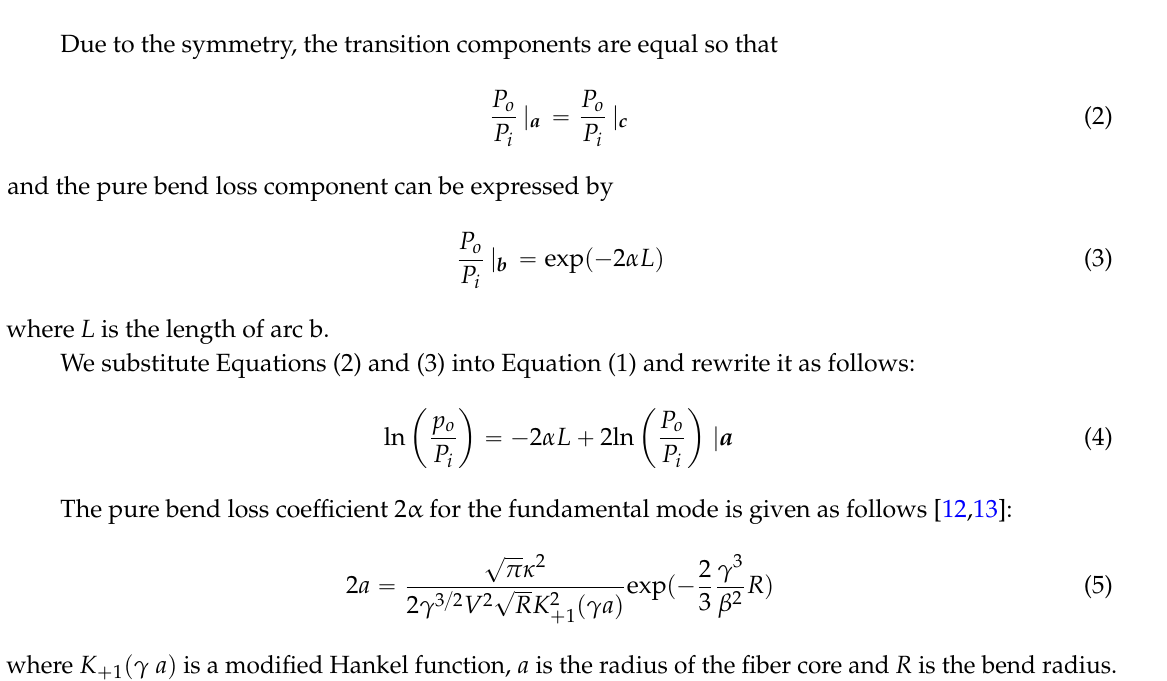
Figure 1. The input power P i and output power P 0 transmission and the optical path formation of the whispering gallery mode generated in a bending single ‐ mode optical fiber.